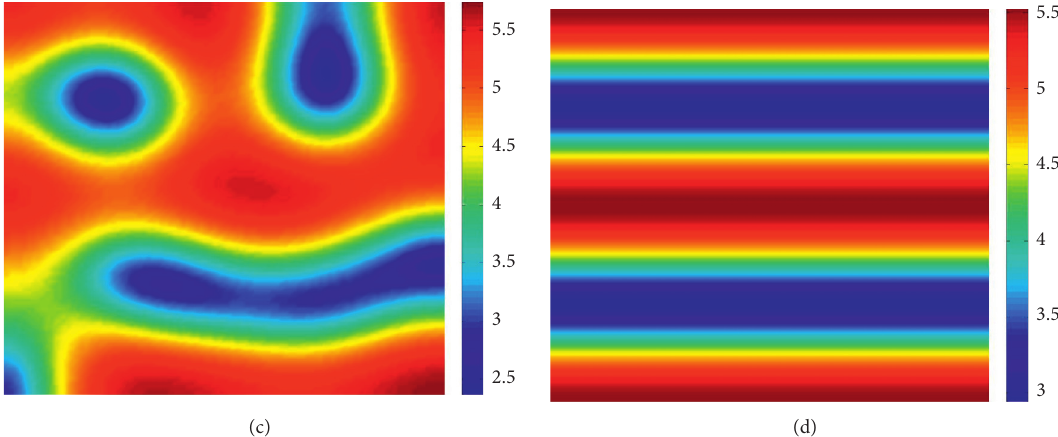
Figure 3: The spatial evolution of the density of the infected with time for time delay τ � 0 . 6: (a) t � 80000; (b) t � 180000; (c) t � 400000; (d) t � 1000000.